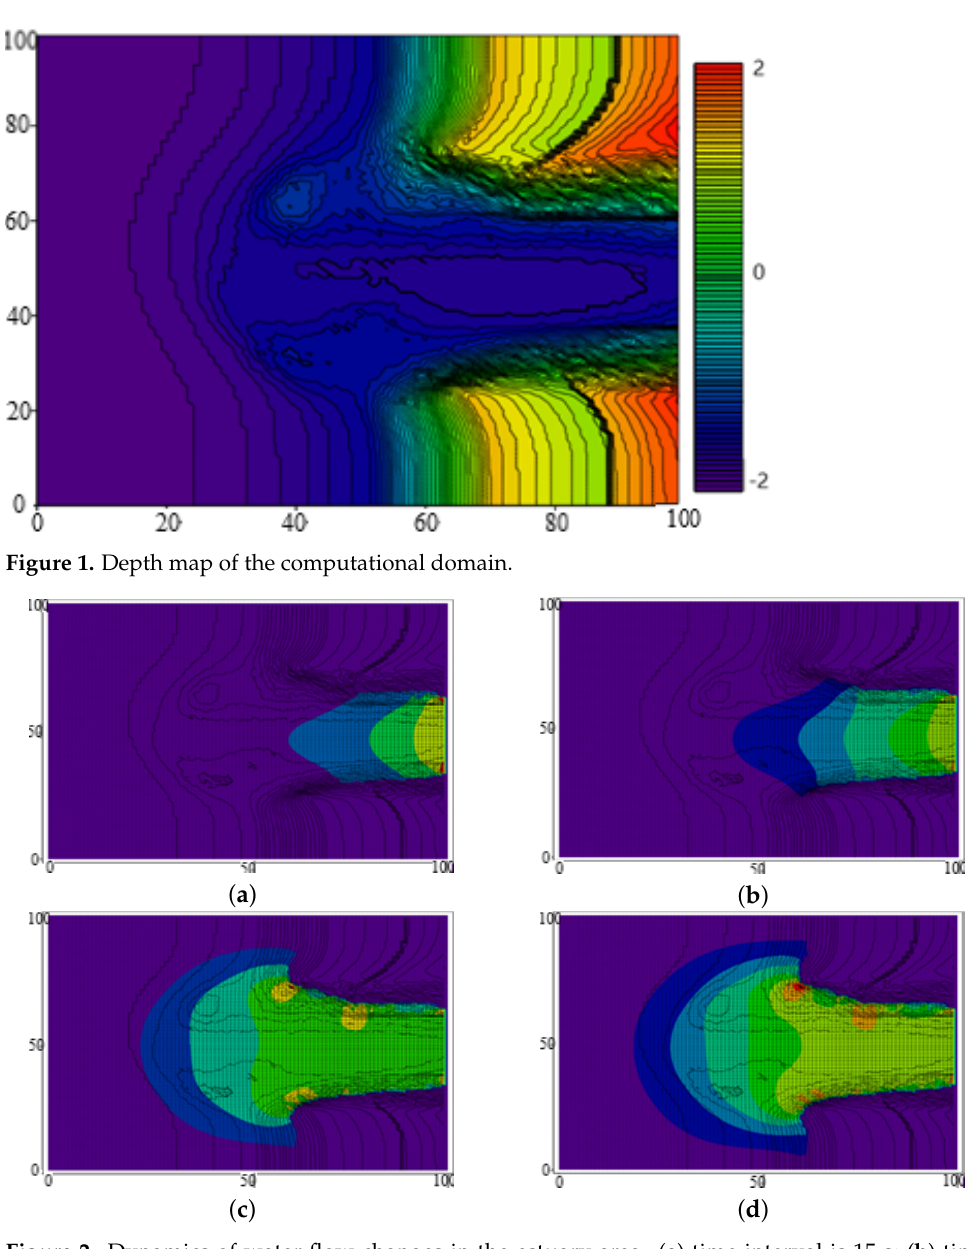
Figure 2. Dynamics of water flow changes in the estuary area. ( a ) time interval is 15 s; ( b ) time interval is 30 s; ( c ) time interval is 45 s; ( d ) time interval is 1